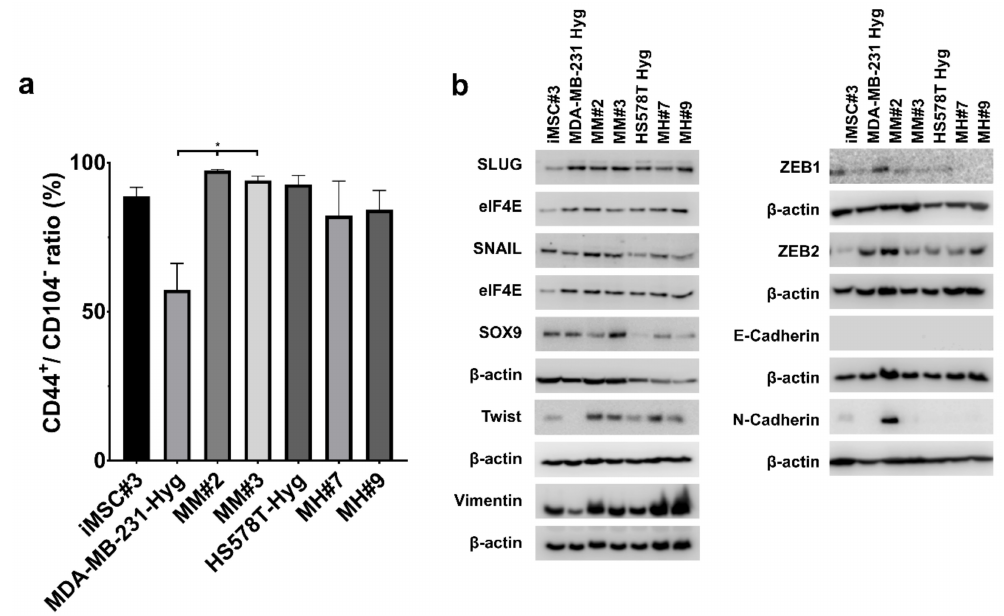
Figure 5. Epithelial to mesenchymal transition (EMT) markers are di ff erentially expressed in hybrid and parental cells. ( a ) Ratio of CD44 + and CD104 − was tested by flow cytometry. Statistical analysis was performed using a one-way ANOVA test: * = p < 0.05. ( b ) Representative results of at least three independent Western blot analyses. The proteins SLUG, SNAIL, SOX9, Twist, vimentin, ZEB1, ZEB2, E-cadherin and N-cadherin were tested. All tested cell lines show individual expression